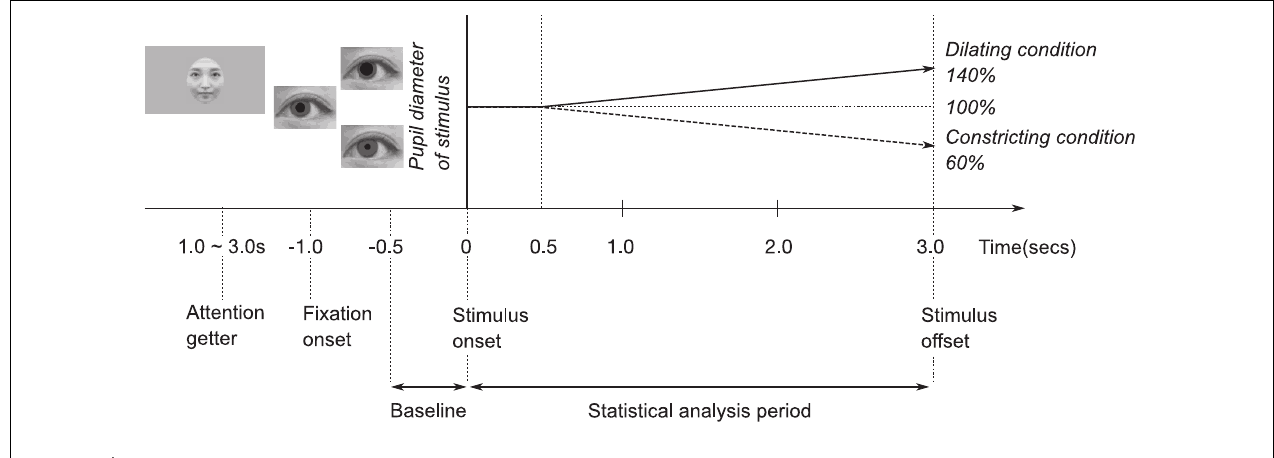
FIGURE 1 | Experimental